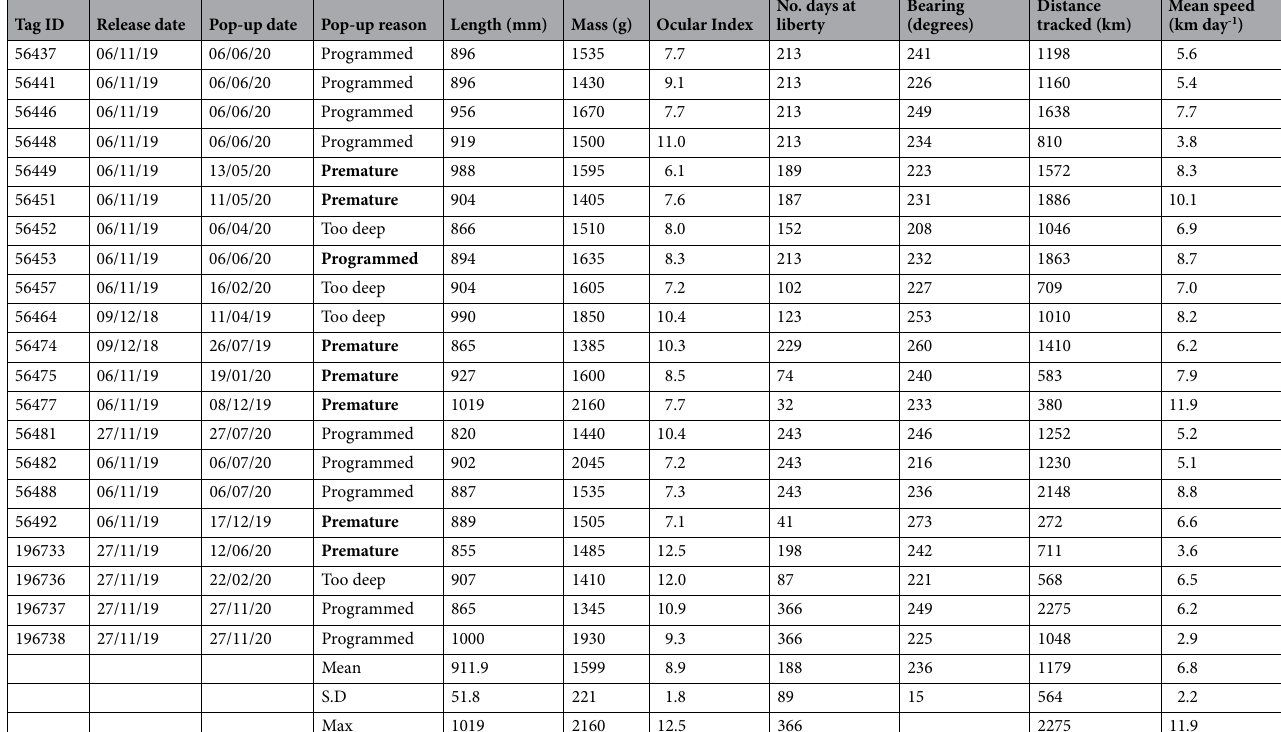
Table 1. Metrics, distance, time and speed of PSAT tagged eels. Data from eels that were predated are not shown. If the surfacing position of tags needed to be back-calculated from surface drift, it is shown in bold against the ‘pop-up